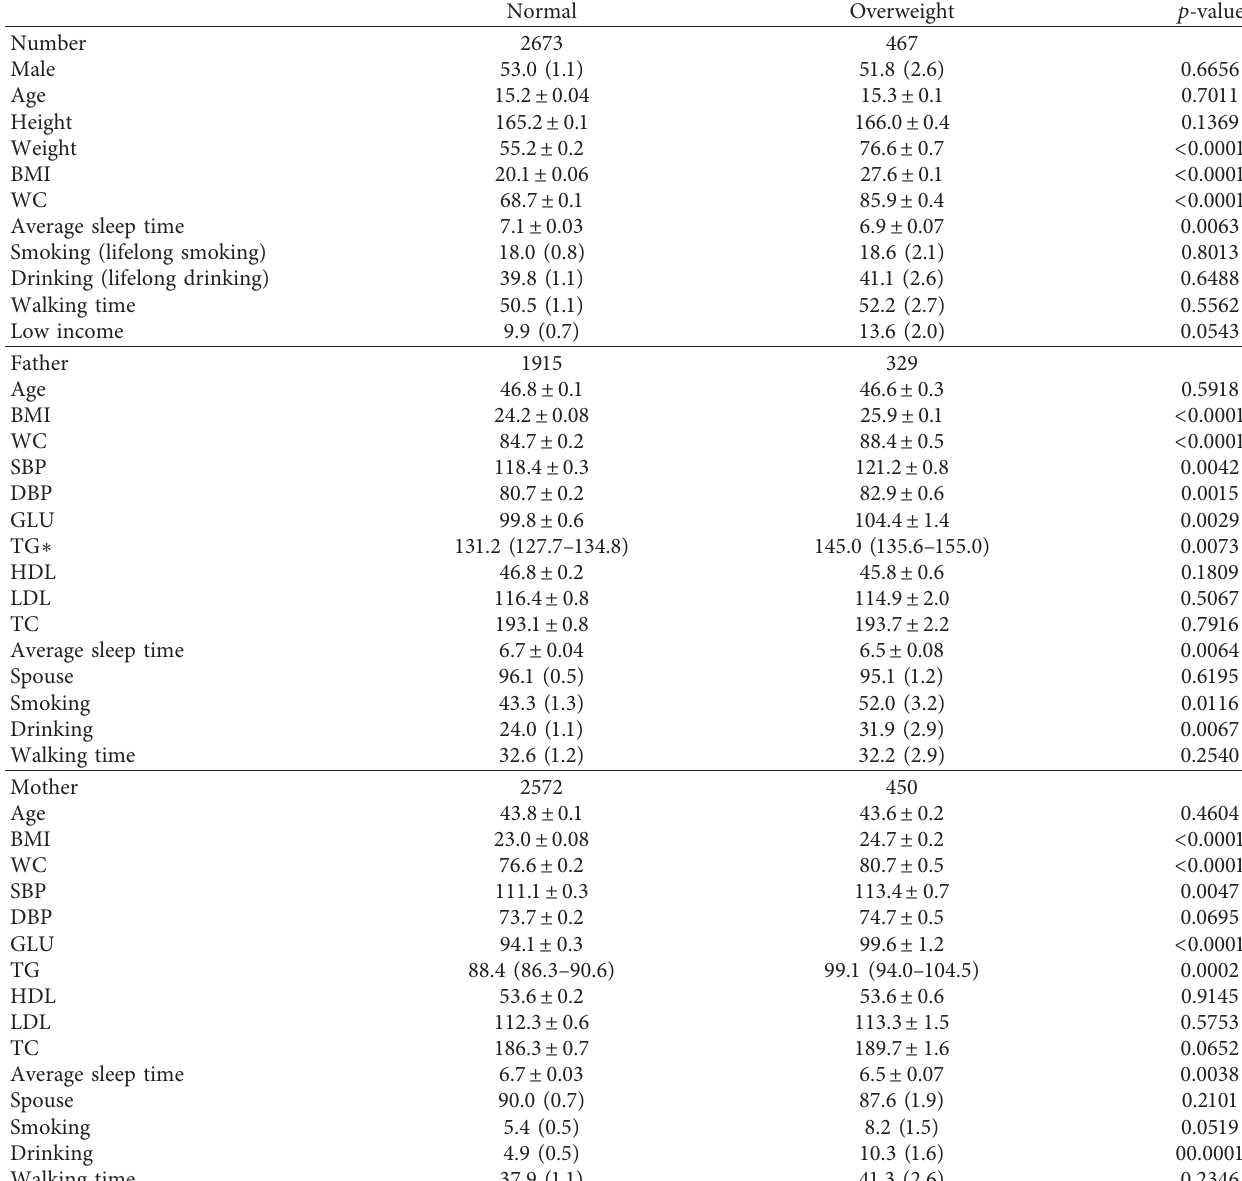
Table 1: Characteristics and laboratory data according to obesity in 12- to 18-year-olds Korean adolescents and their parents. Normal Overweight p